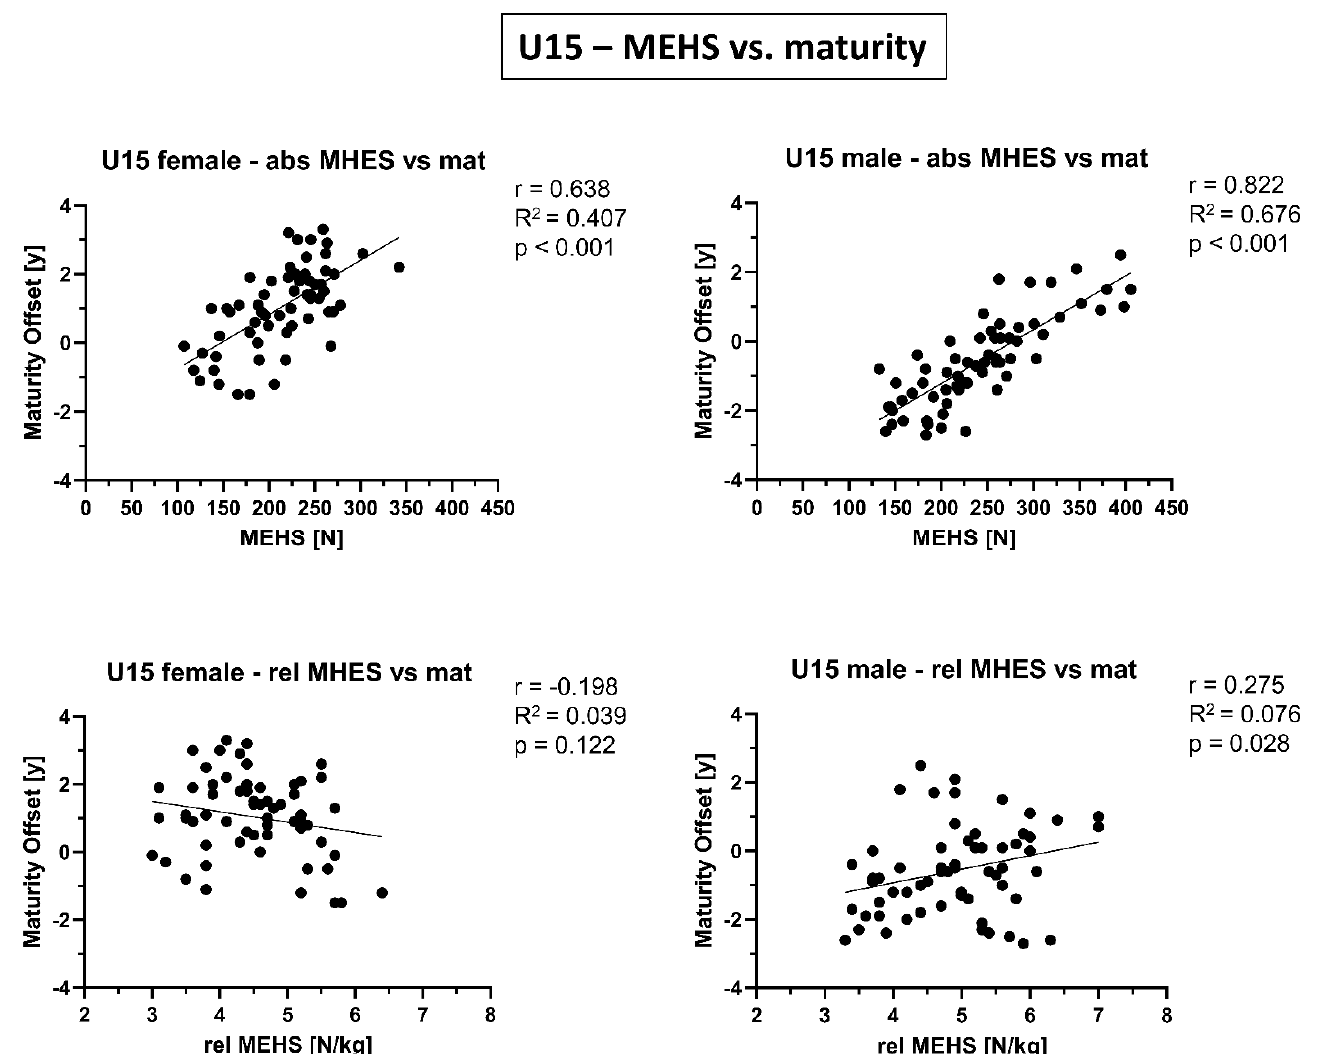
Figure 4. Correlations of absolute (abs) and relative (rel) maximal eccentric hamstring strength (MEHS) with maturity offset for competitive alpine skiers under 15 years old (U15) separated by sex.